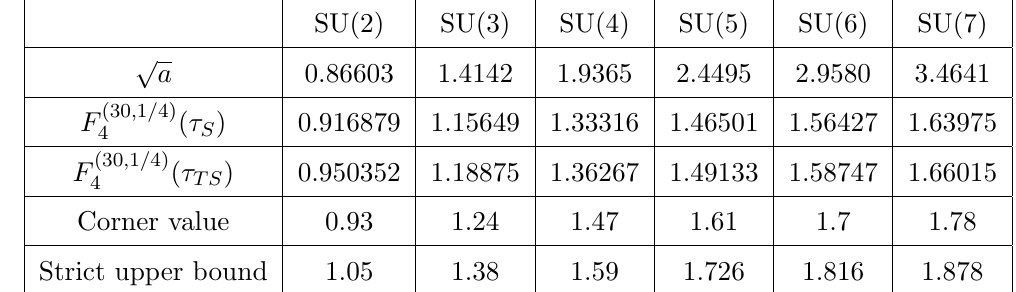
Table 2 . The interpolating function for spin-0 at the duality invariant points and data from the N = 4 superconformal